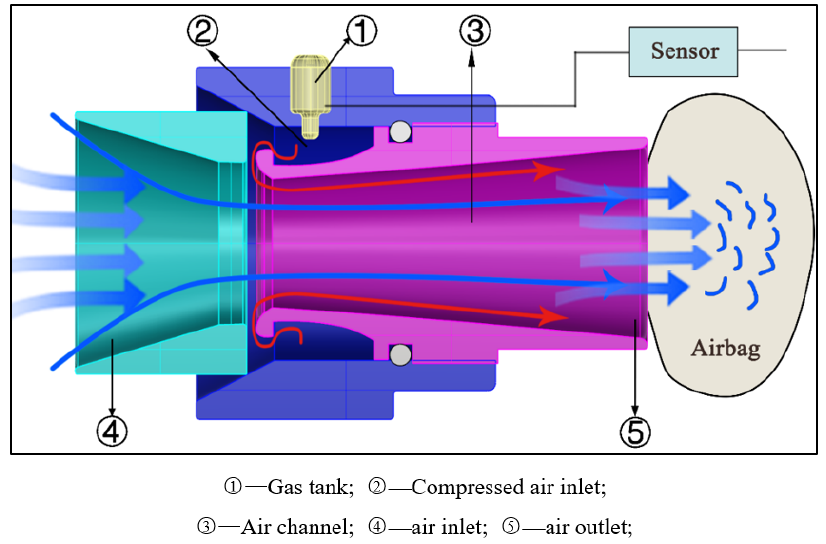
Figure 12. Radical concept design of an aspirated gas generator.